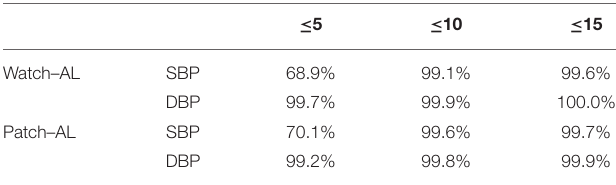
TABLE 3 | Percent of observations obtained from the wristwatch and chest-patch configurations of a wearable, non-invasive sensor that were within 5, 10, and 15 mmHg of those obtained by an arterial line.